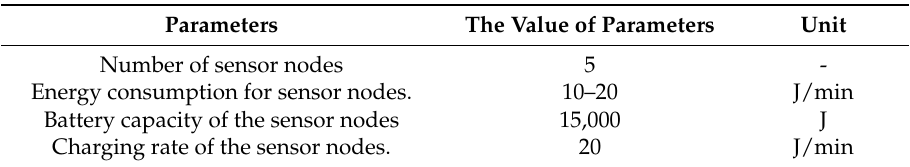
Table 4. Assumed parameters of the